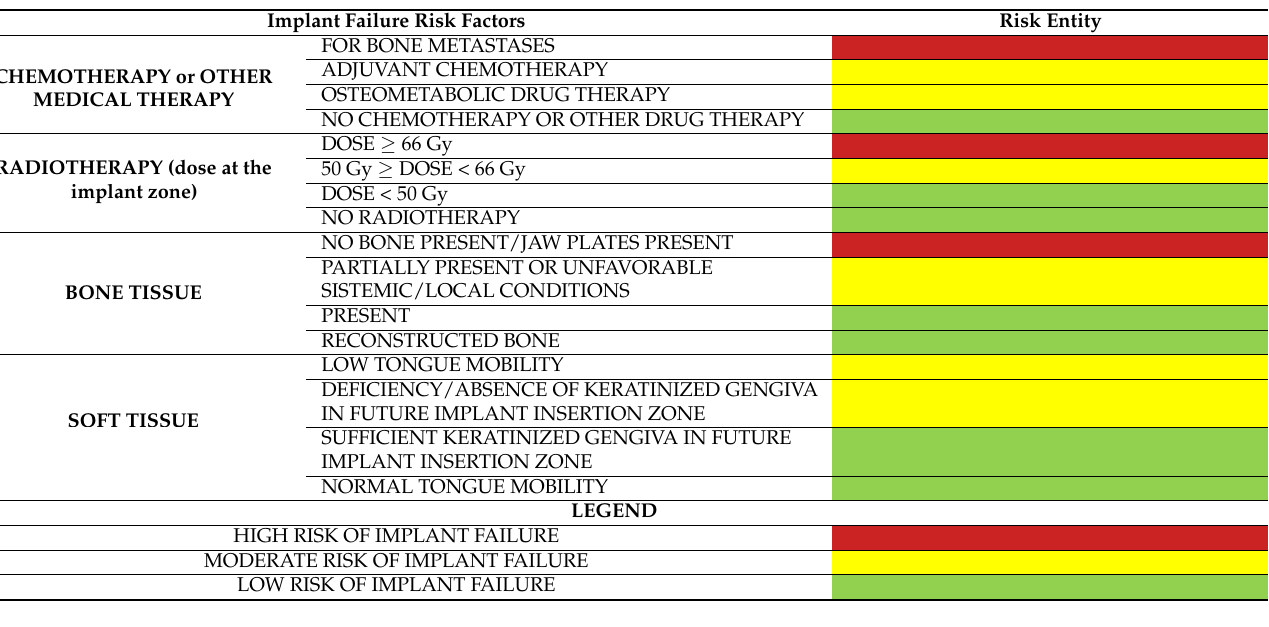
Table 1. Implant failure risk assessment